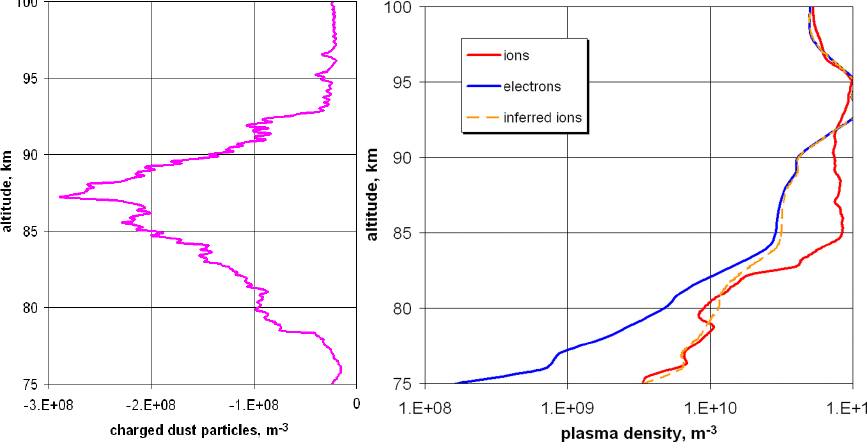
Fig. 7. As in Fig. 4, but flight 41.094 (upleg data). The charged dust particles are of the mass range 500 to 2,000 amu.